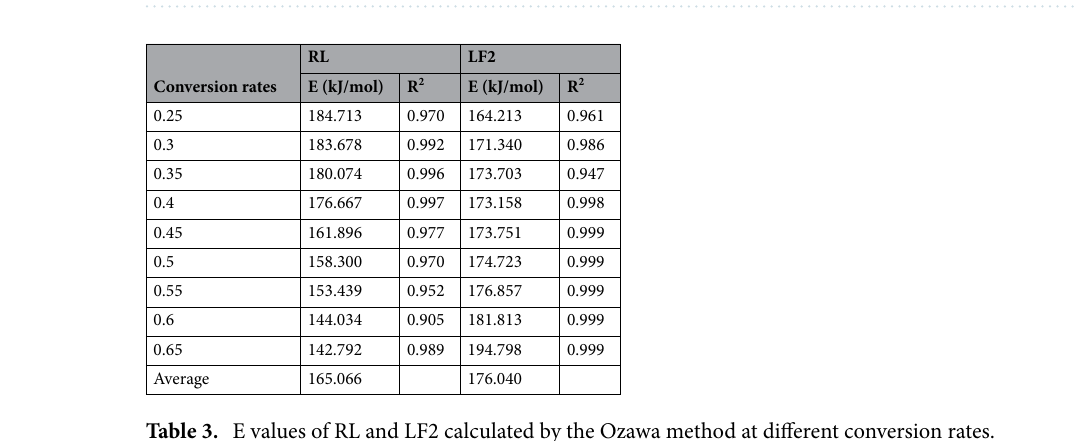
Figure 6. Plots of ln β vs 1/T at different conversion rates by Ozawa method ( a ) RL and ( b ) LF2.